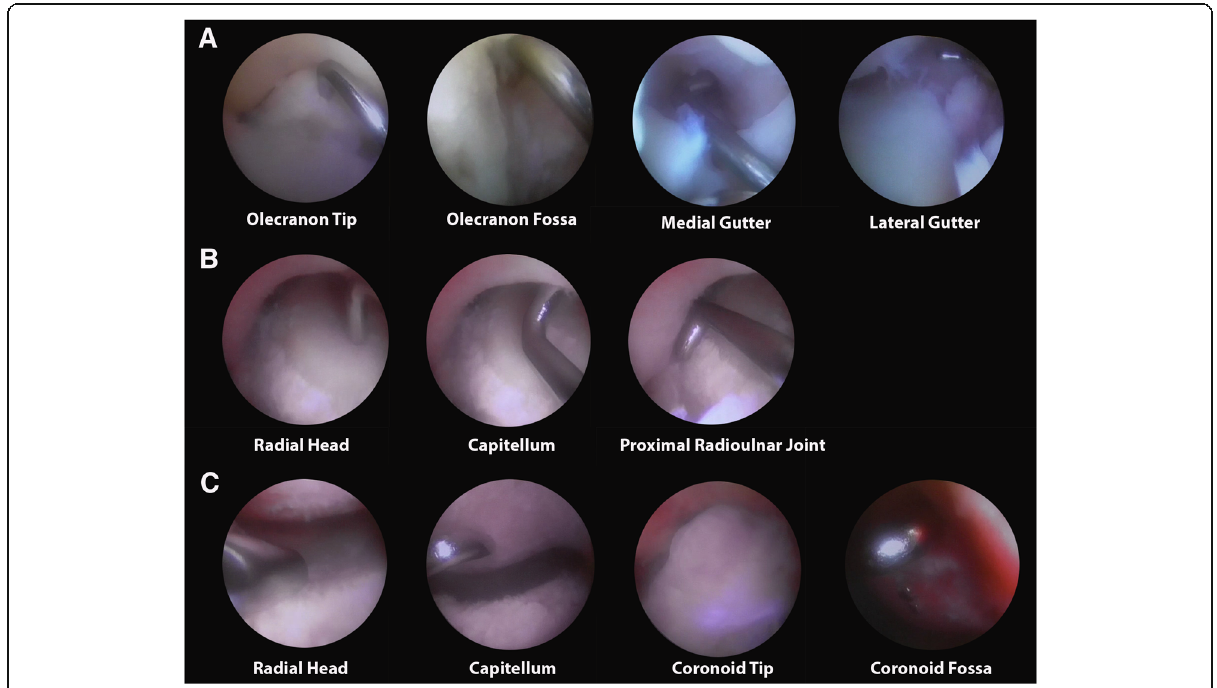
Fig. 2 Arthroscopic views of predefined landmarks per compartment. a Posterior compartment. b Posterolateral compartment. c Anterior